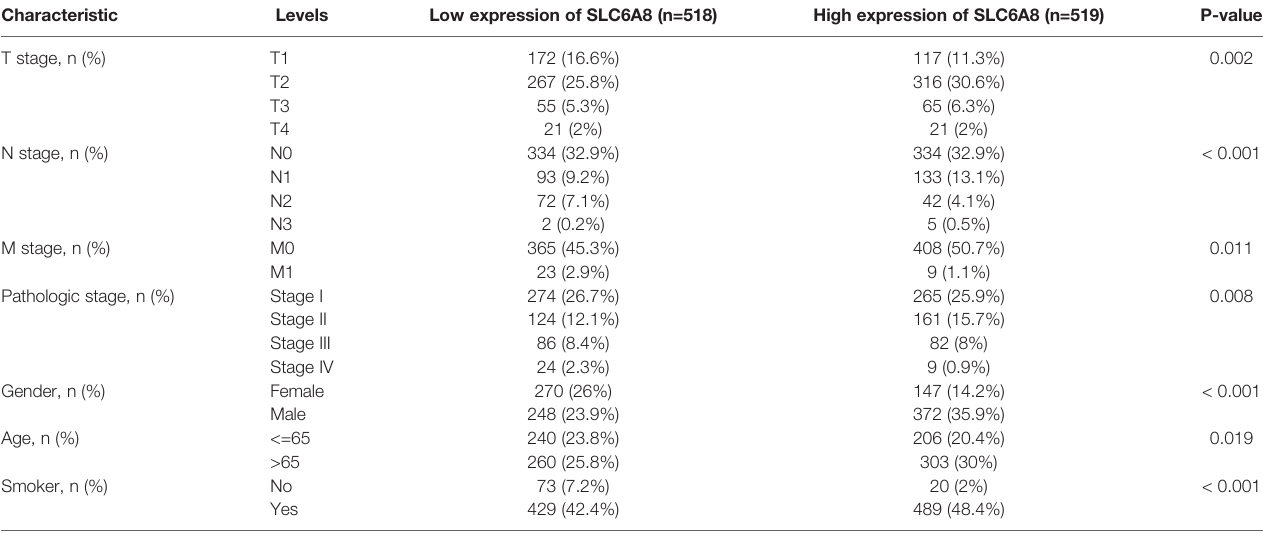
TABLE 1 | Correlation of SLC6A8 expression with clinicopathological characteristics of NSCLC. Characteristic